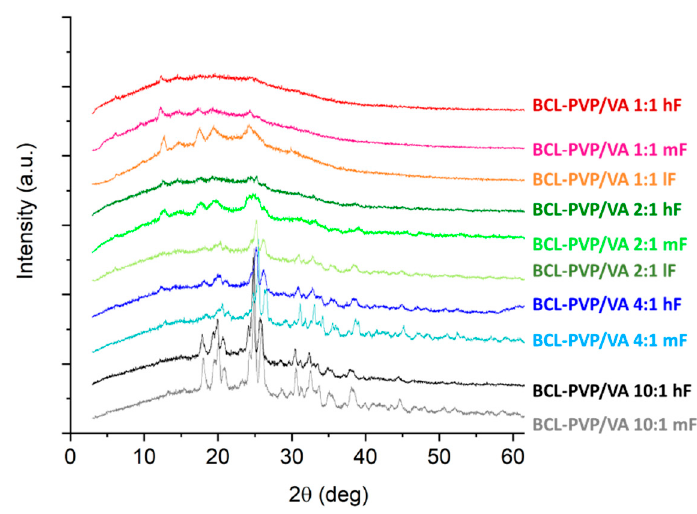
Figure 9. X-ray di ff raction patterns of tablets containing BCL physically mixed with PVP / VA (hF, mF, Figure 9. X-ray diffraction patterns of tablets containing BCL physically mixed with PVP/VA (hF, mF, and lF represent high, medium, or low compression force, and lF represent high, medium, or low compression force, respectively).